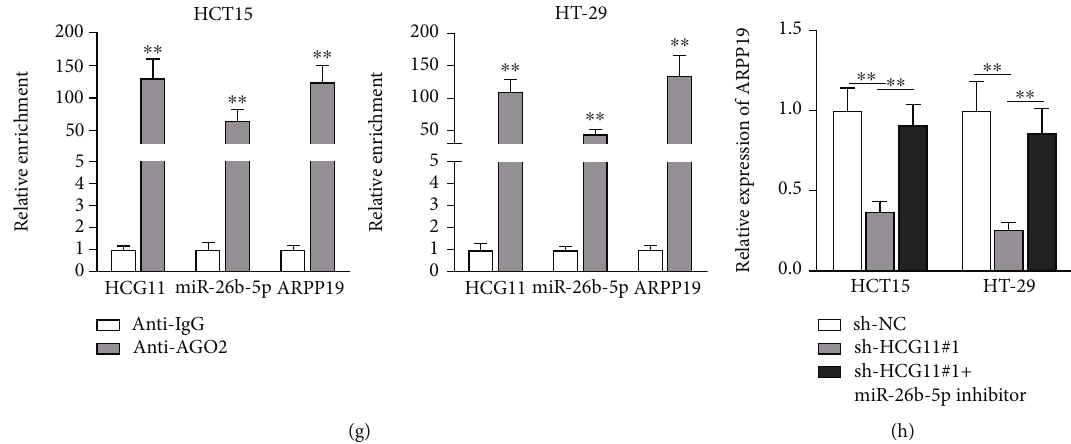
Figure 3: ARPP19 is the downstream gene of miR-26b-5p in CRC cells. (a) The microT, miRanda, miRmap, PITA, and TargetScan databases jointly predicted underlying target genes of miR-26b-5p. (b) The mRNAs downregulated upon HCG11 knockdown and miR- 26b-5p overexpression were screened as the candidates. (c) Expressions of 5 candidate mRNAs in CRC cell lines relative to NCM-460 cells were measured via qRT-PCR. (d) Western blot analyzed the expression of ARPP19 in di ff erent cell lines. (e) The binding sites between miR-26b-5p and ARPP19 were acquired after ENCORI prediction. (f) Luciferase reporter assay was done to verify the interaction between miR-26b-5p and ARPP19. (g) The existence of HCG11, miR-26b-5p, and ARPP19 in anti-AGO2 was detected by RIP assay. (h) ARPP19 expression was assessed via qRT-PCR in cells with transfection of sh-HCG11#1 or sh-HCG11#1+miR-26b-5p inhibitor. ∗∗ p < 0 : 01